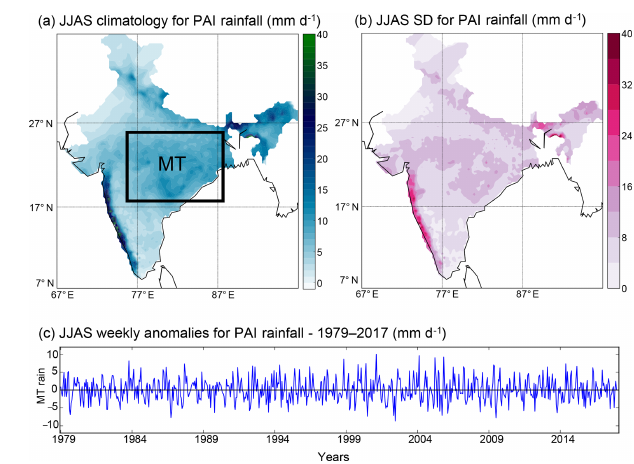
Figure 1. Rainfall climatology over the study area. (a) JJAS rainfall climatology over the 1979–2017 period from the Pai et al. (2015) dataset. The black box identifies the MT region. (b) Standard devi- ation (SD) of weekly JJAS rainfall over the 1979–2017 period from the Pai et al. (2015) dataset. (c) Time series of weekly MT JJAS rainfall over the period 1979–2017; each year contains 18 weeks, with the first week starting on 27 May.